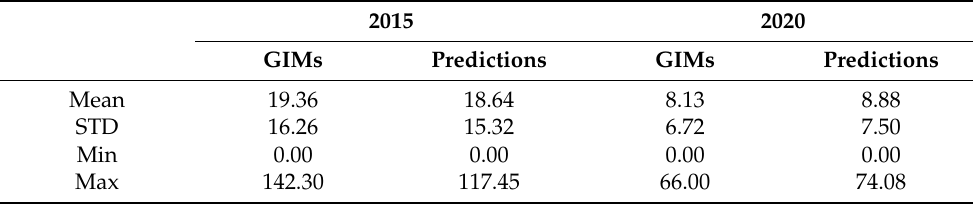
Table 2. Quality measures of the Global Ionosphere Maps (GIMs) and